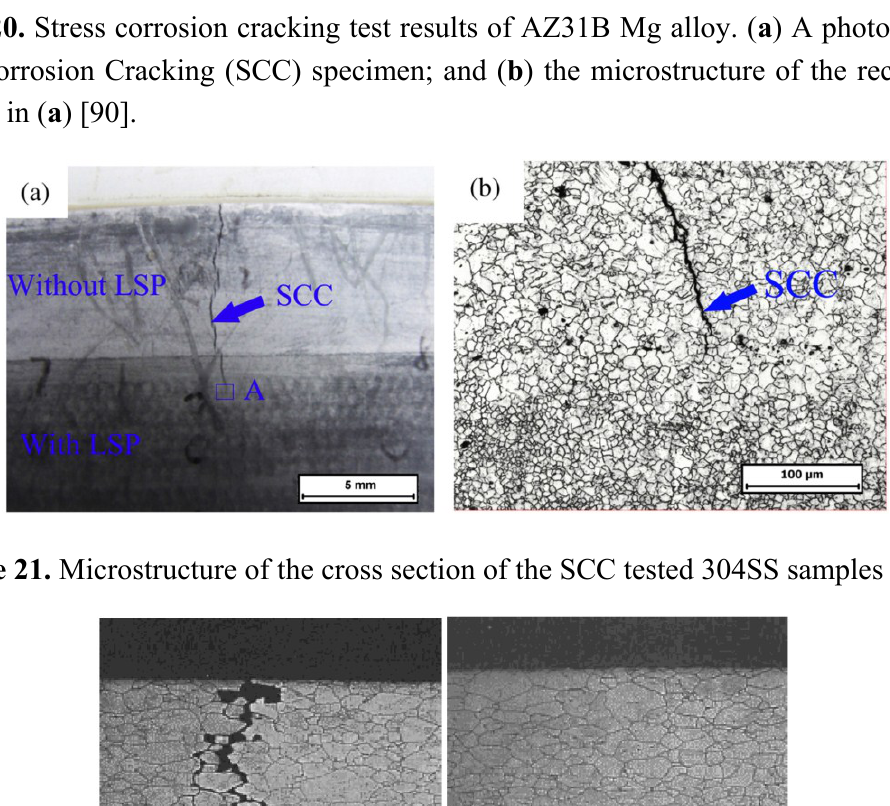
Figure 20. Stress corrosion cracking test results of AZ31B Mg alloy. ( a ) A photograph of